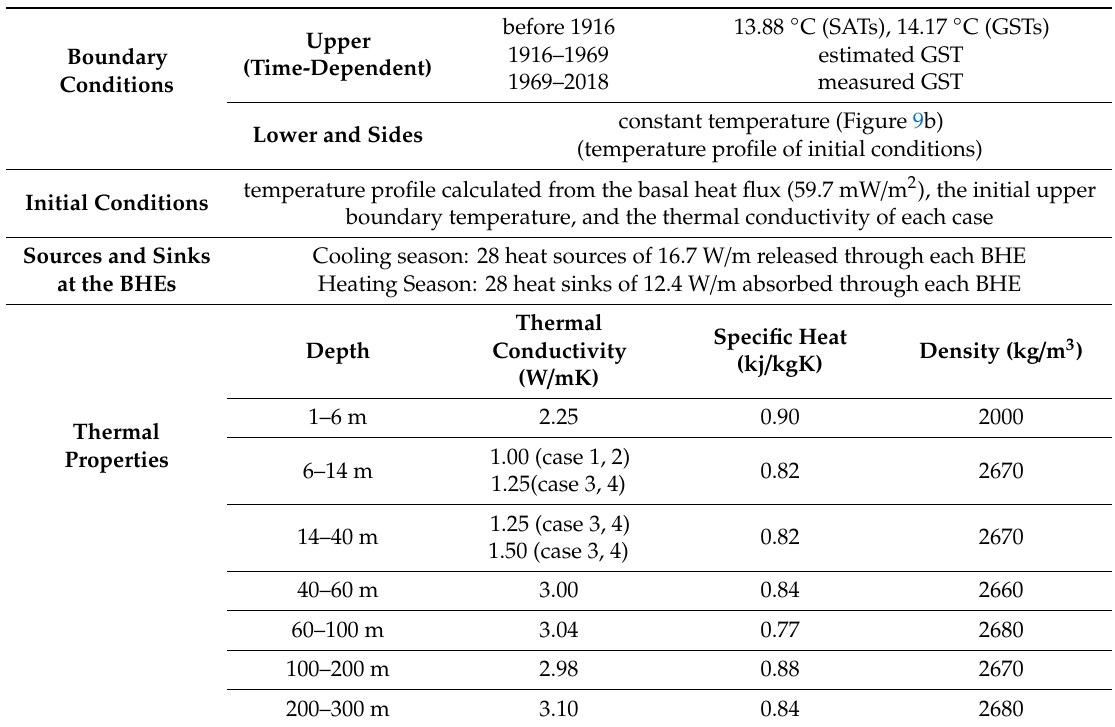
Table 4. Summary of boundary and initial conditions, and thermal properties used for